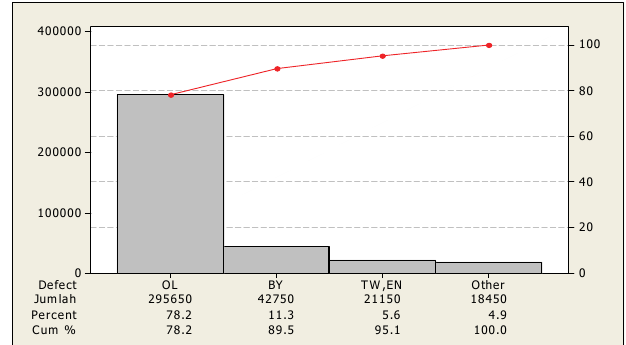
Fig. 1. Pareto Diagram of Nonconforming Products Causative